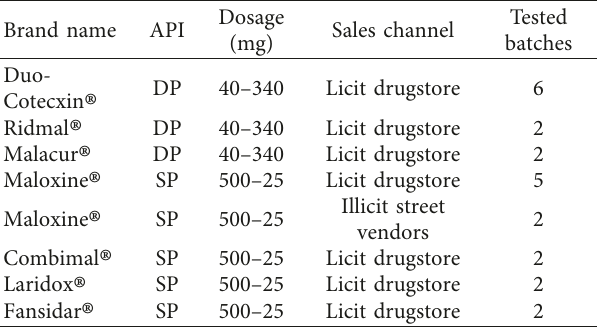
Table 1: DP and SP collected